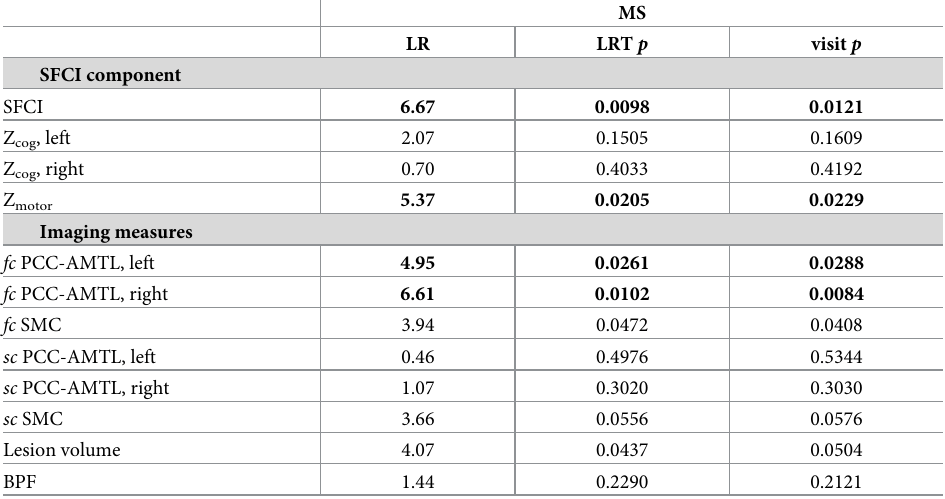
Table 4. The impact of time (visit) on SFCI components and associated measures in participants with MS.